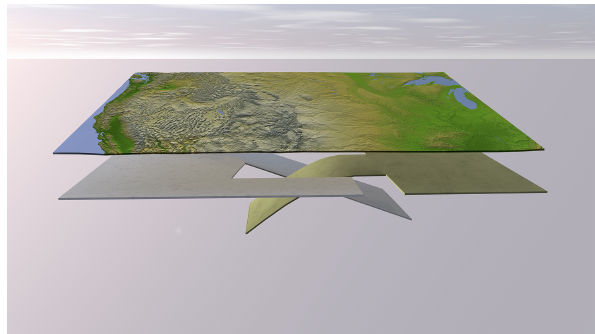
Figure 12. Visualization of the interfingering of the colliding Far- allon LAB in the west with the Laurentia MLD in the east. The cratonic LAB is left out of the figure. The profiles in Figs. 9a, b, c and 10 (48–50, 41–43, and 33–38 ◦ N) represent the east-dipping part of the Farallon LAB in the north, the west-dipping Laurentia MLD and the flat part of the far-east-reaching Farallon plate in the south. The lateral transition between these three parts is in reality not as sharp as indicated here, but much more